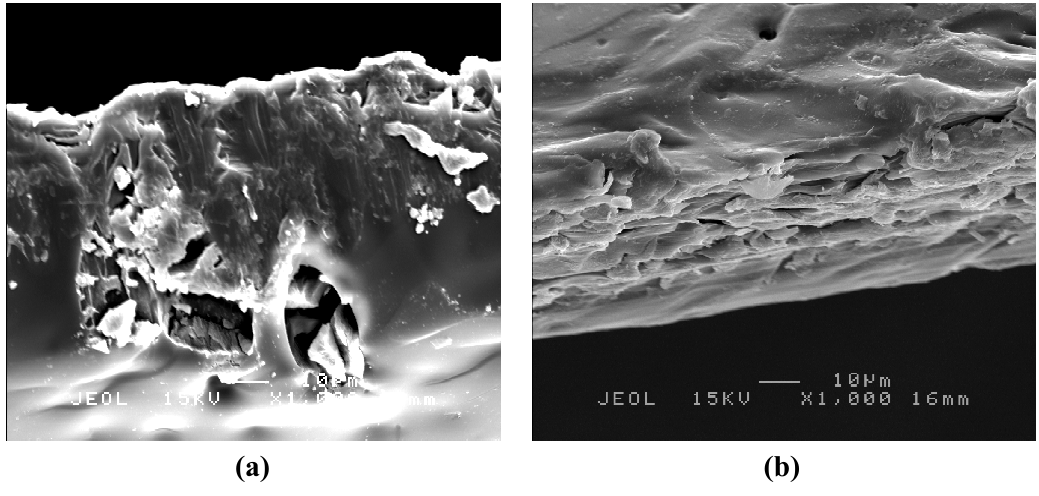
Figure 5. Cross section of ( a ) PSf-MB-MIP membrane and ( b ) PSf